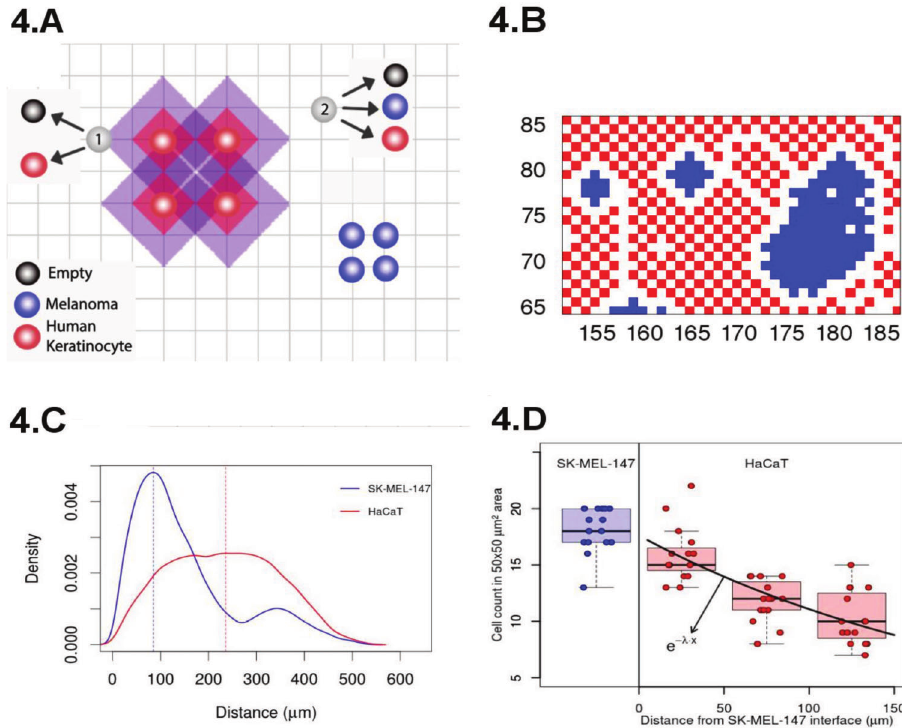
Figure 4 - ( A ) Cartoon of our model for proliferation under different allelophylic degrees. ( B ) Spatial configuration achieved in our simulations at the co-culture confluence regime. ( C ) Experimental cell-to-cell distance distribution (the blue/red curve indicates the cancer/normal cells histogram). ( D ) Normal-to-normal (red) and melanoma-to-melanoma (blue) cell count in a 50 (cid:4) 50 m m 2 region as they are further away from the interface with the melanoma